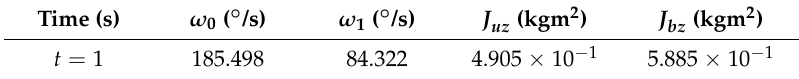
Table 9. Inertia simulation data in adams.